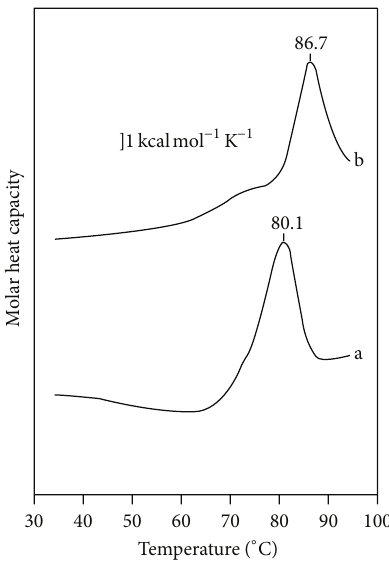
Figure 4: DSC thermograms of (a) apo- and (b) holo-GW7647 human L-FABP. The 𝑇 𝑚 is indicated above each thermogram. The scan rate was 0.5 ∘